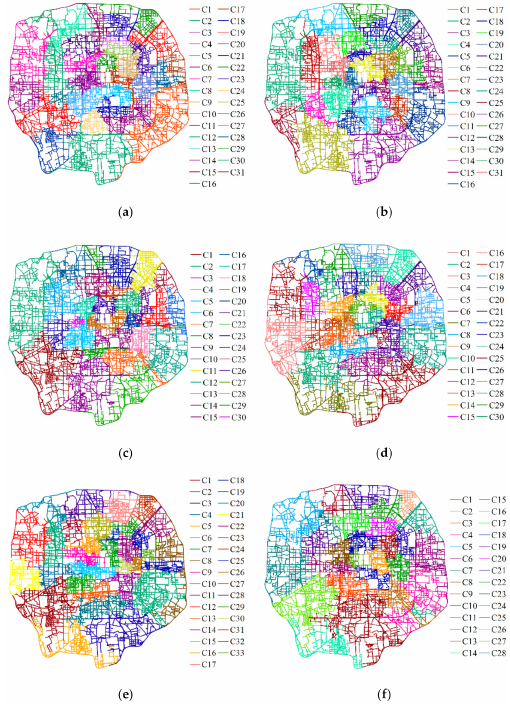
Figure 11. Communities discovered by FacetNet: ( a ) 8:00–9:00; ( b ) 9:00–10:00; ( c )